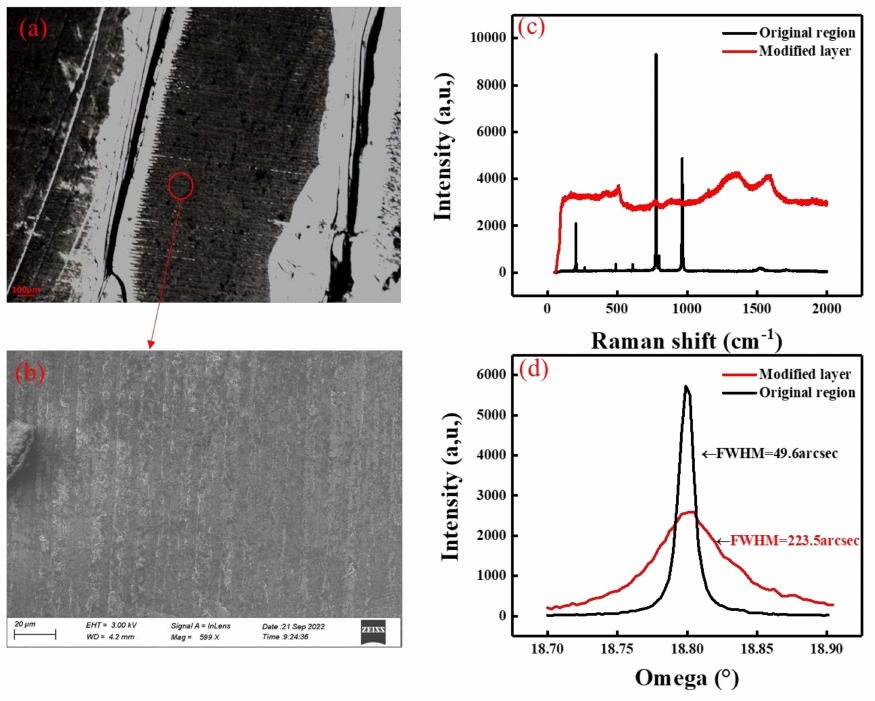
Figure 11. ( a ) The microscopic observation of the modified layer. ( b ) SEM image of the modified layer. ( d ) Raman spectrum of the modified layer. ( c ) X-ray double crystal diffraction rocking curve of the modified